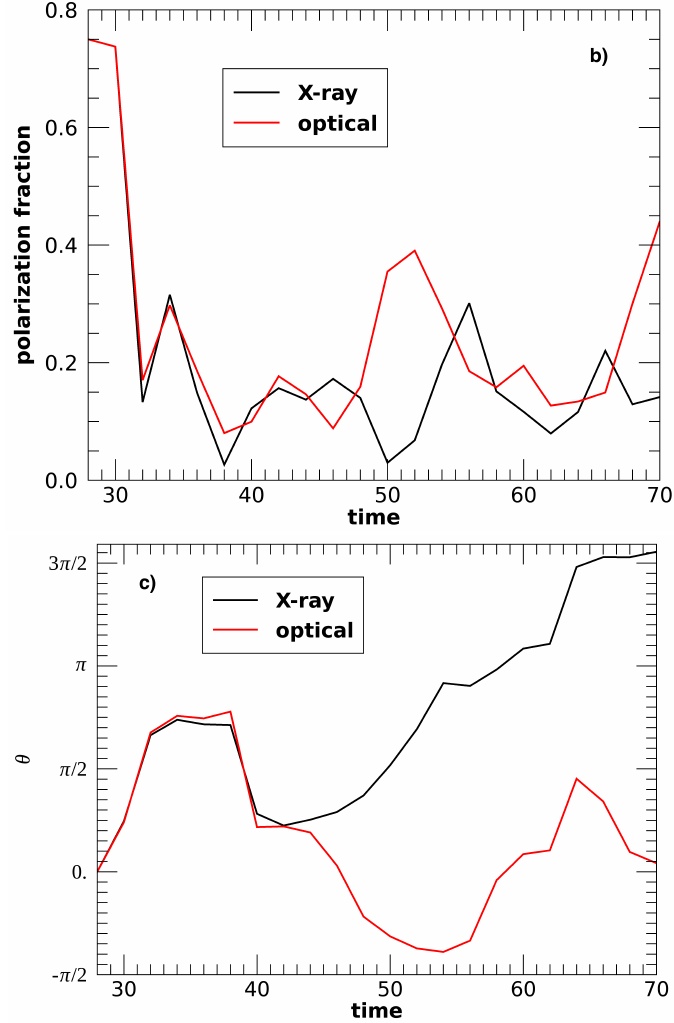
Figure 8. ( a ) Plot of the total emission in the X-ray (black) and optical (red) bands as a function of time for the simulation presented in [68]. Each curve is normalized to its peak value. ( b ) Polarization fraction in the X-ray (black) and optical (red) bands as a function of time. ( c ) Evolution of the polarization angle of the integrated emission as a function of time (colors as above). From [68]. Reproduced with kind permission from Oxford University Press and the Royal Astronomical